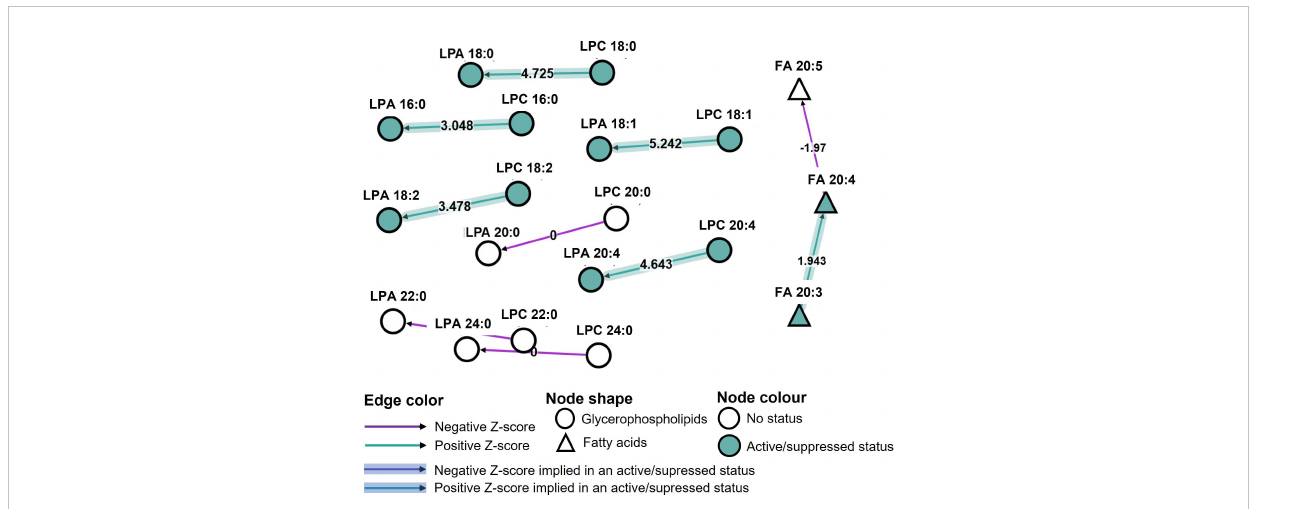
FIGURE 6 Pathway analysis of lipidomic data from Single Donor Apharesis during storage and in the event of adverse reactions. BioPan pathway analysis of lipidomic data from SDA-PC with and without occurrence of AR, regardless of storage